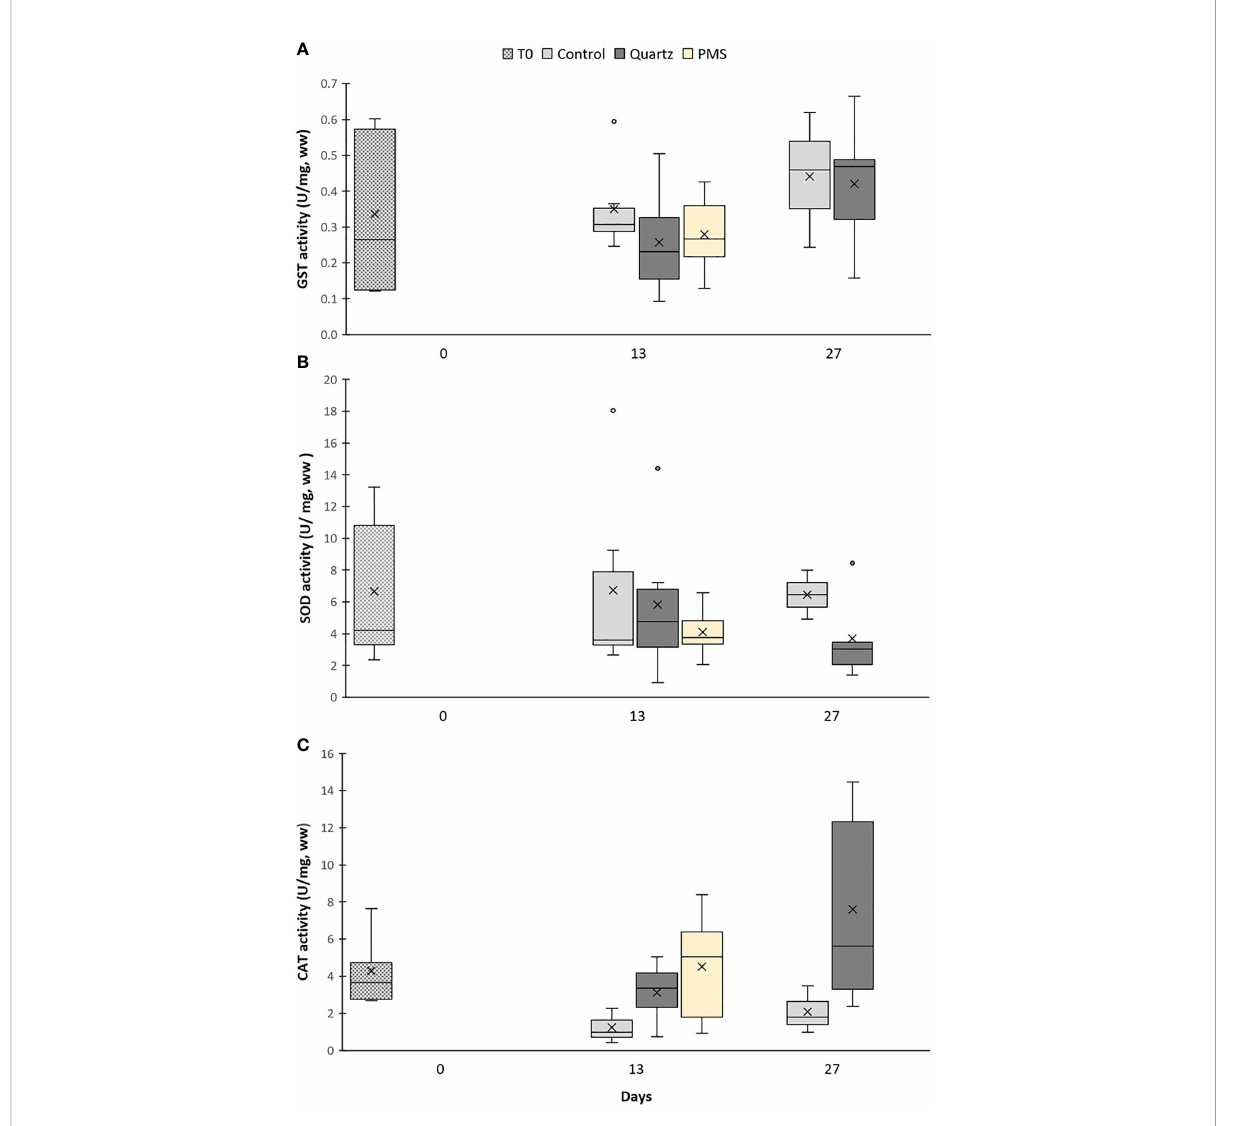
FIGURE 7 Enzyme activities of (A) Glutathione S − transferase (GST), (B) superoxide dismutase (SOD) and (C) catalase (CAT) in Dentomuricea aff. meteor tissues during the experiment (times 0, 13, 27) in treatments with polymetallic particles (PMS), with quartz particles (Quartz) and in the control treatments with no sediment addition. N=3-6, no fragments in the PMS treatment at T27. The line in the box is the median, and the X is the mean. Whiskers represent the highest and lowest values and outliers are identi fi ed by a circle ( ○